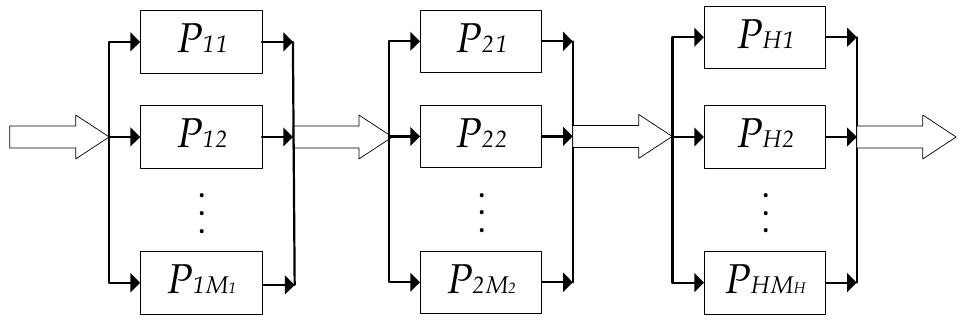
Figure 4. The use of parallel processors in relation to pipeline strategy.